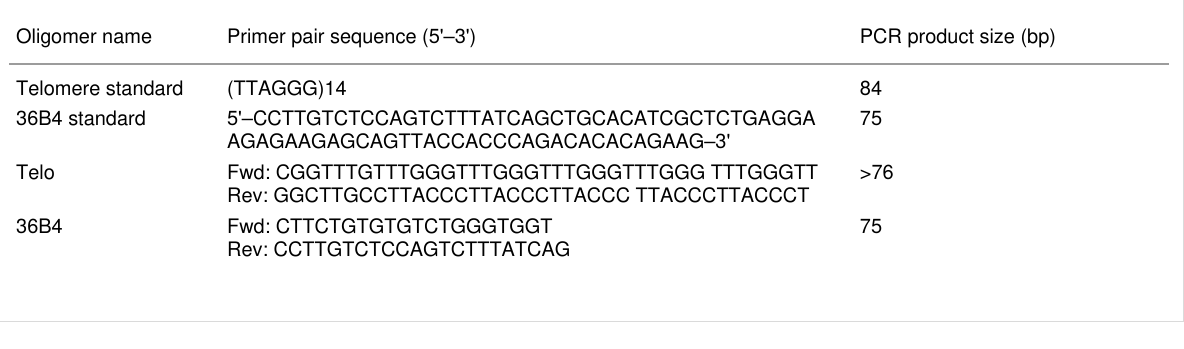
Table 2: Primer sequences used for the aTL measurement.